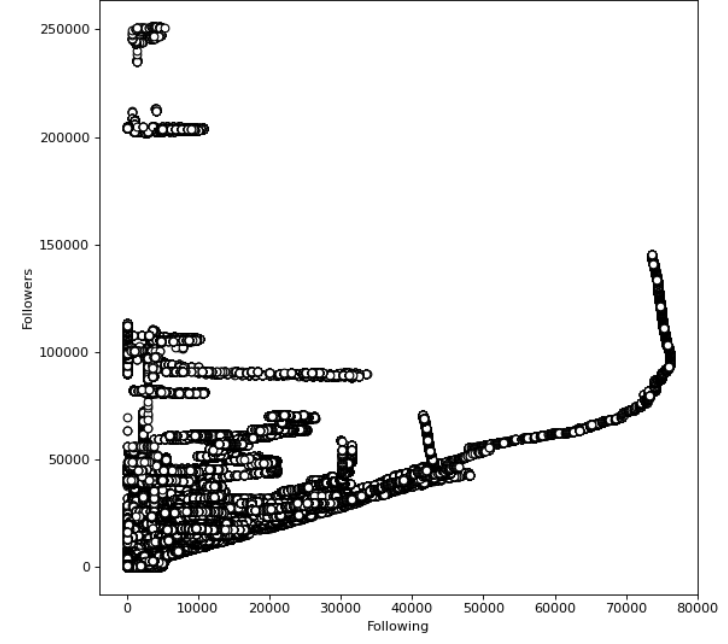
Figure 1. Number of Followers and